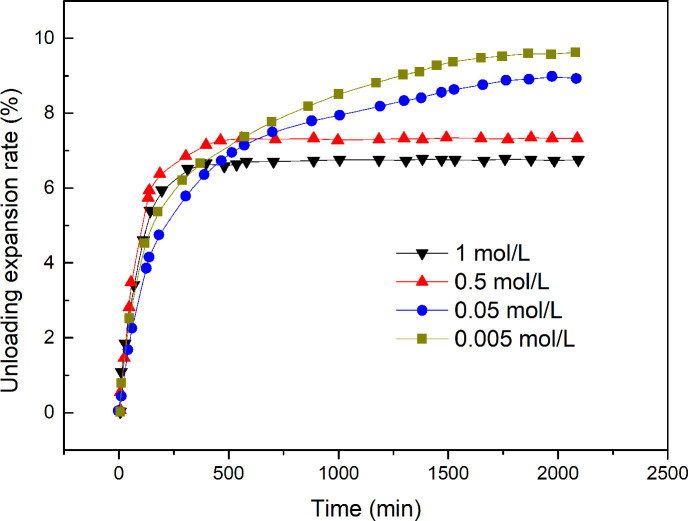
Time-dependent unloading expansion rate of expansive soils containing different concentrations of NaCl.